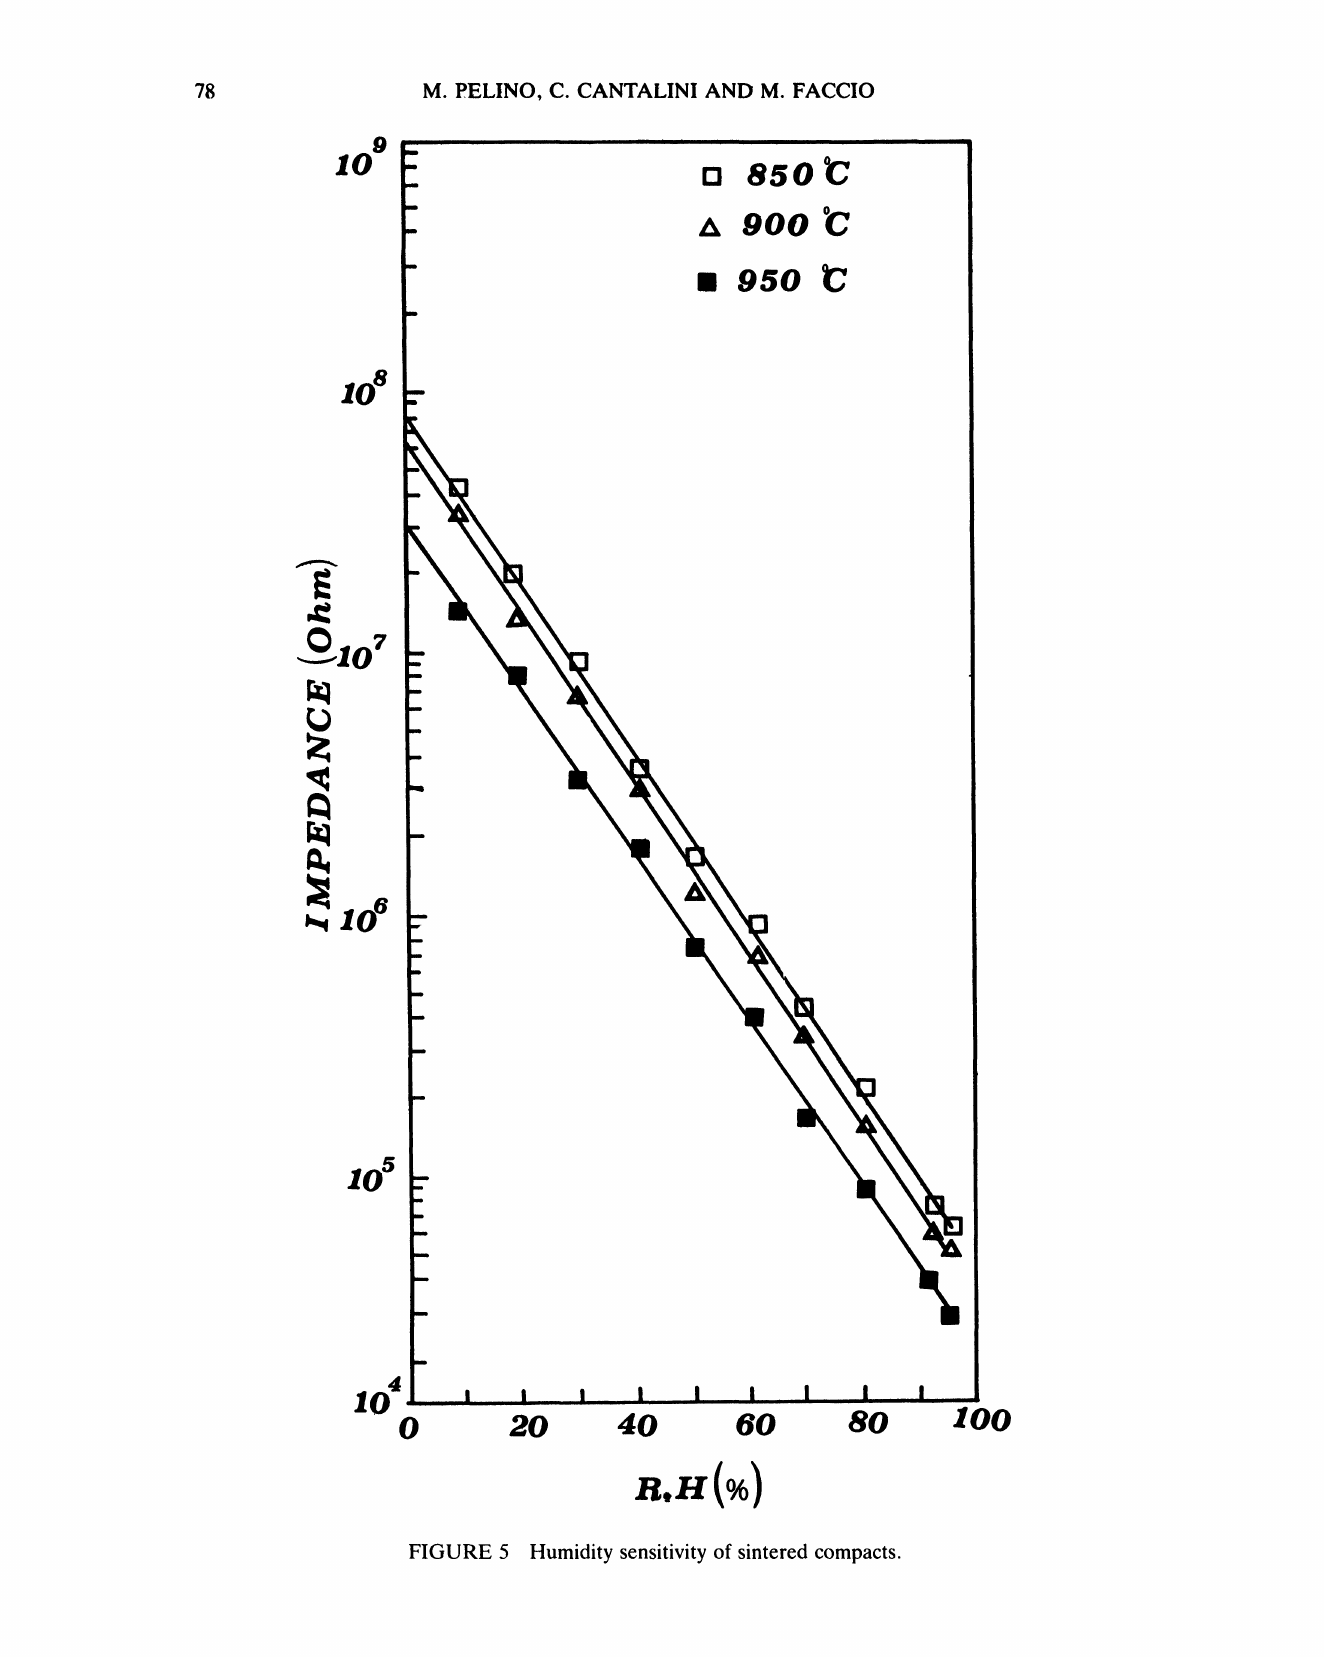
FIGURE 5 Humidity sensitivity of sintered